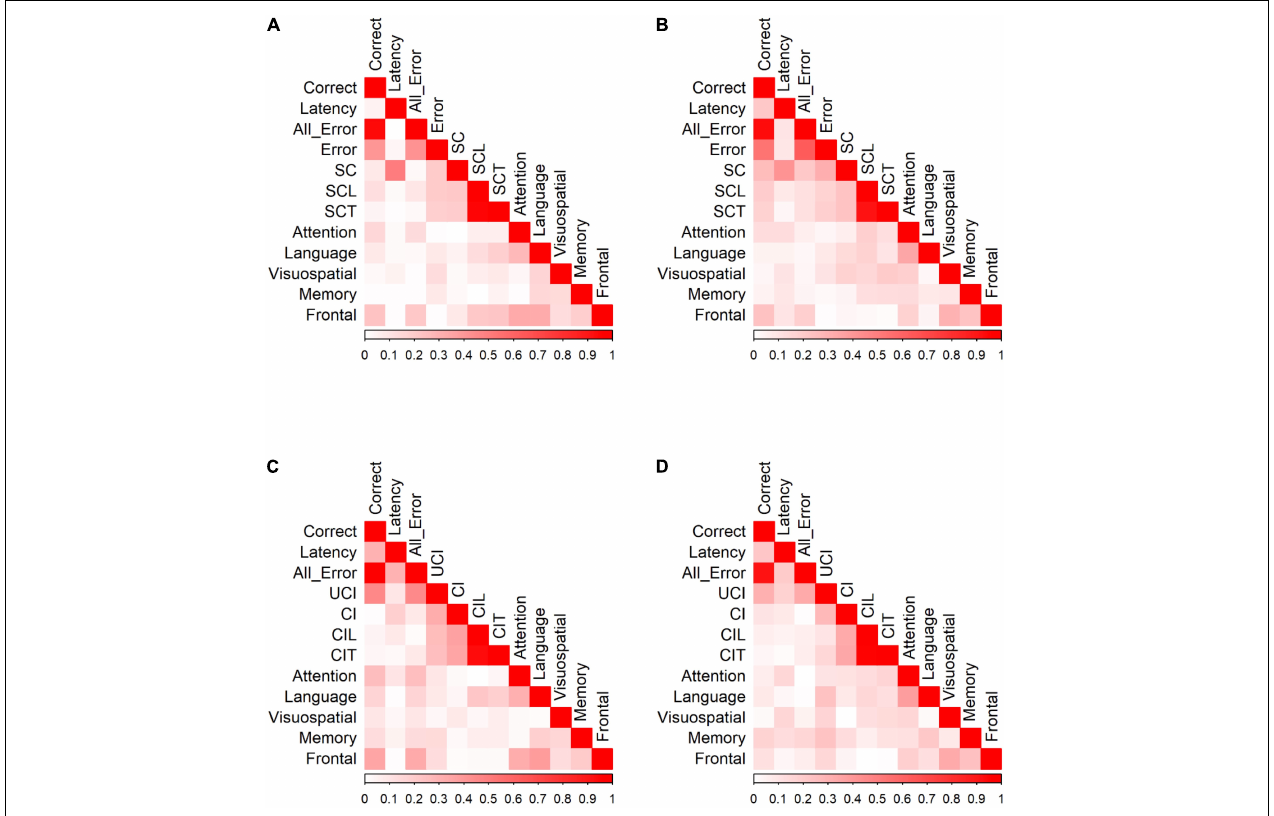
FIGURE 4 | Correlation of PS/AS responses and neuropsychological tests for (A) PS responses by HC. (B) PS responses by MCI patients. (C) AS responses by HC. (D) AS responses by MCI patients. Data were presented with the absolute values of Pearson correlation coefficients; exact values and p- values are presented in Supplementary Table 2 (HC) and Supplementary Table 3 (MCI). SC, self-corrected errors; SCL, self-corrected latency; SCT, self-corrected time; UCI, uncorrected-inhibition errors; CI, corrected inhibition errors; CIL, corrected inhibition latency; CIT, corrected inhibition time. Weak correlations, near 0, are in white while those nearing 1 are in red, portraying strong correlations. Pearson’s correlations are in absolute